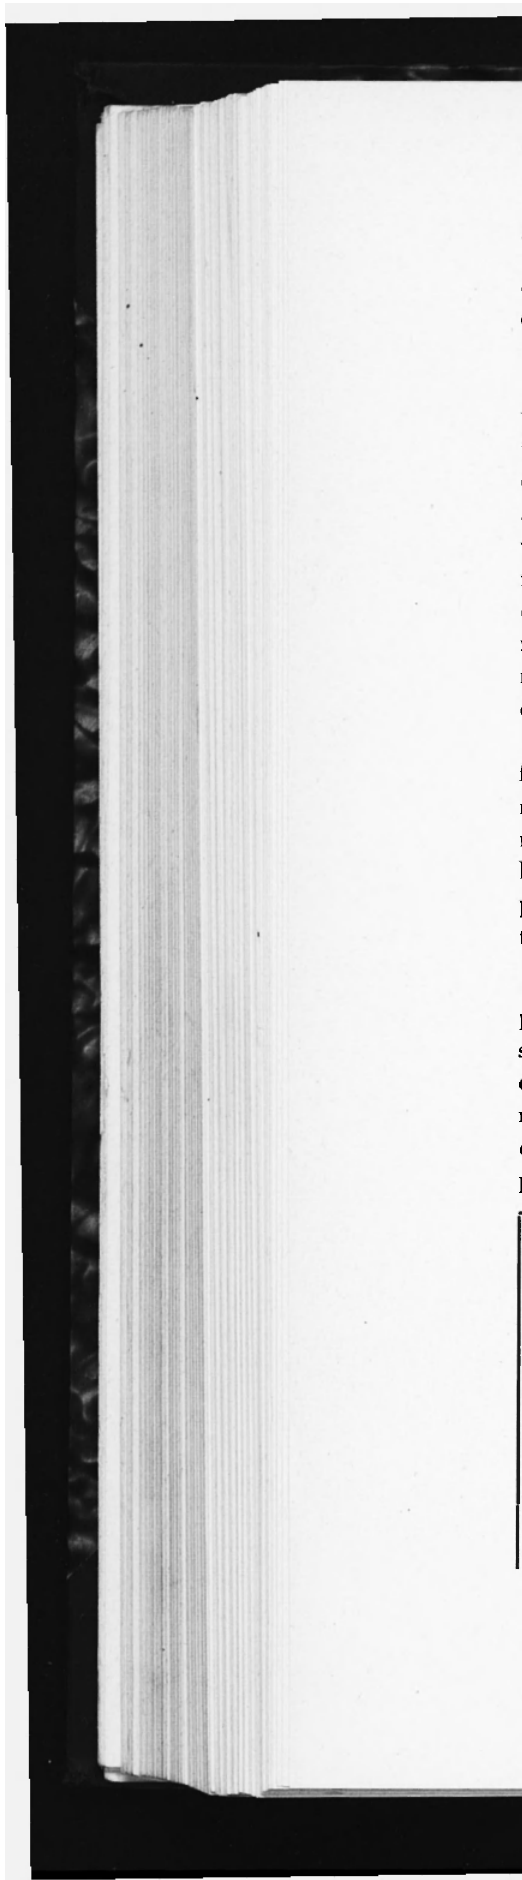
Abbiamo scelto 7 impulsi nell'interval- lo più interessante della registrazione. Applicando le formule precedentemente indicate si ricavarono i seguenti risultati fig. 2 e 3 velocità periodo n.